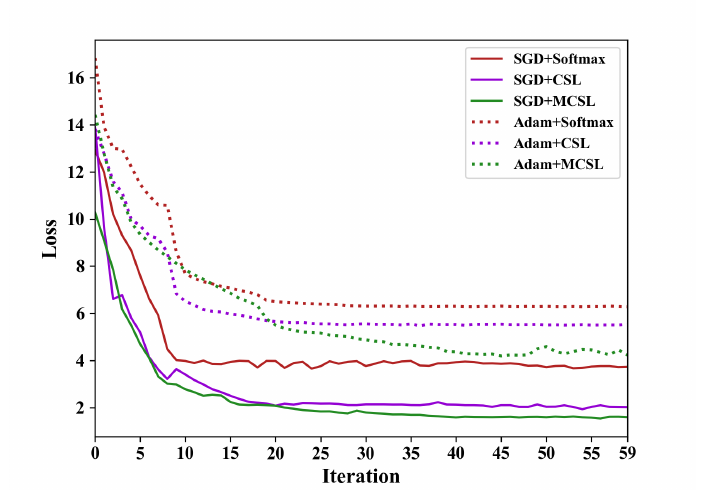
Figure 5. The mean training loss curves from 5 runs of softmax, CSL, and MCSL optimized by Adam and SGD on the Market-1501 dataset. The horizontal and vertical coordinates represent the iteration number and the loss value, respectively.